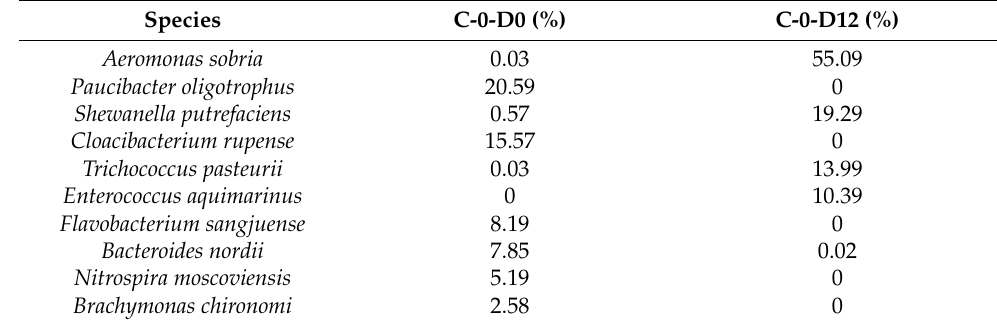
Table 1. The abundance of species for crawfish stored at 4 ◦ C in vacuum packaging.